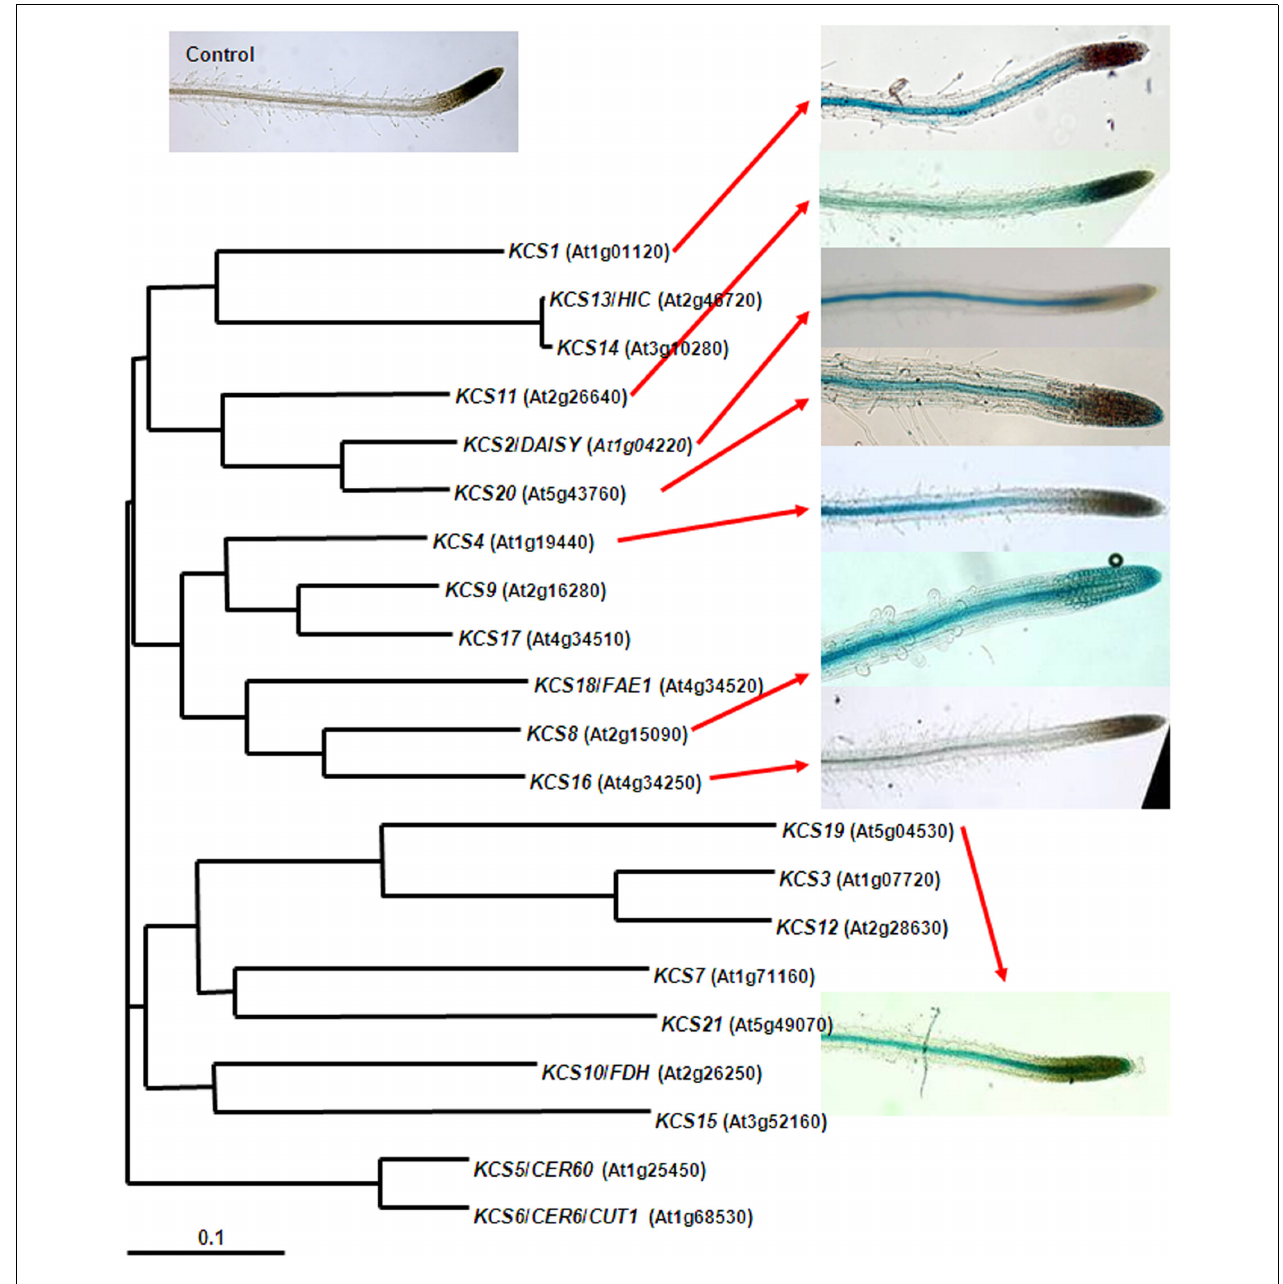
Pro FAE–KCS :GUS transgenic lines were incubated in a GUS staining solution for 2–4h as described Franke et al. (2009) and microscopically inspected. A transgenic line transformed with the same, but promoter-less, GUS containing vector was similar treated to serve as a control (top